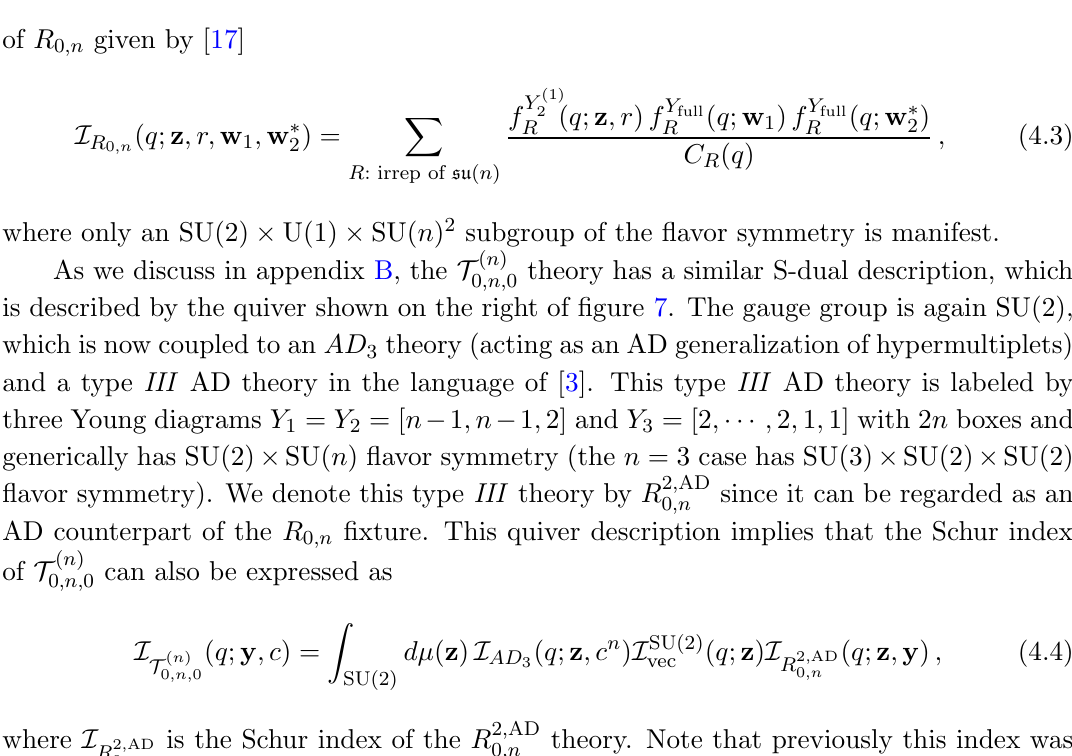
Figure 8 . The pants decomposition for the punctured sphere corresponding to the S-dual descrip- tion of L ( n ) shown on the left of (cid:12)gure 7. The left and right spheres correspond to a fundamental 0 ;n; 0 hypermultiplet and R 0 ;n respectively, while the middle cylinder corresponds to the SU(2) vector